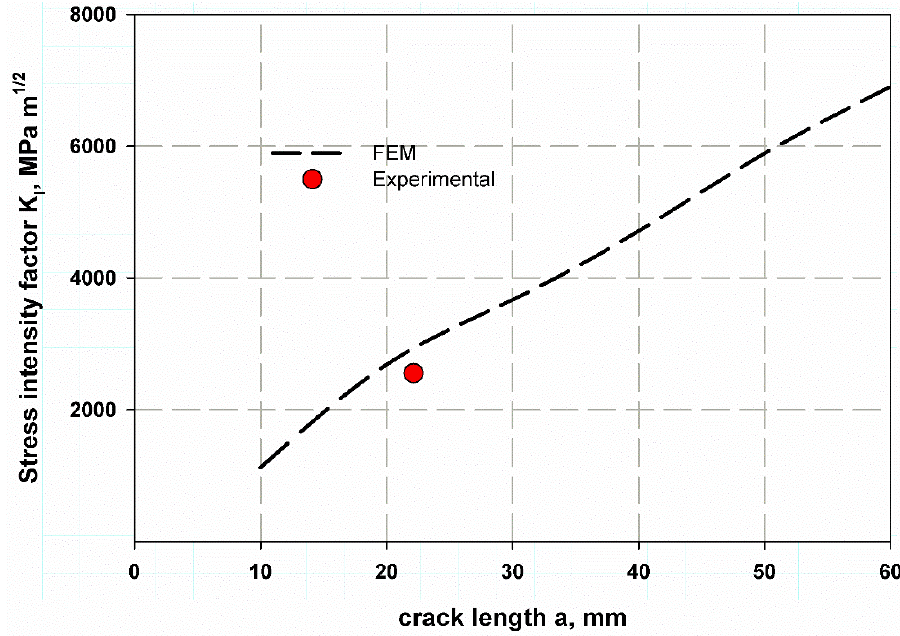
Figure 15. Stress intensity factor for thin-walled composite cylinder under internal pressure. Table 3. Influence coefficients Y for stress intensity factor with linear and nonlinear curve fitting.